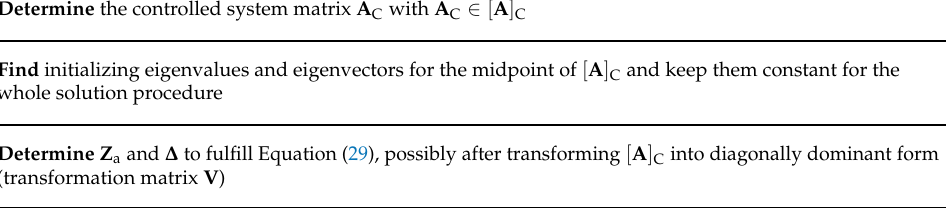
Algorithm 1: LMI-based computation of the transformation matrix Θ = VS